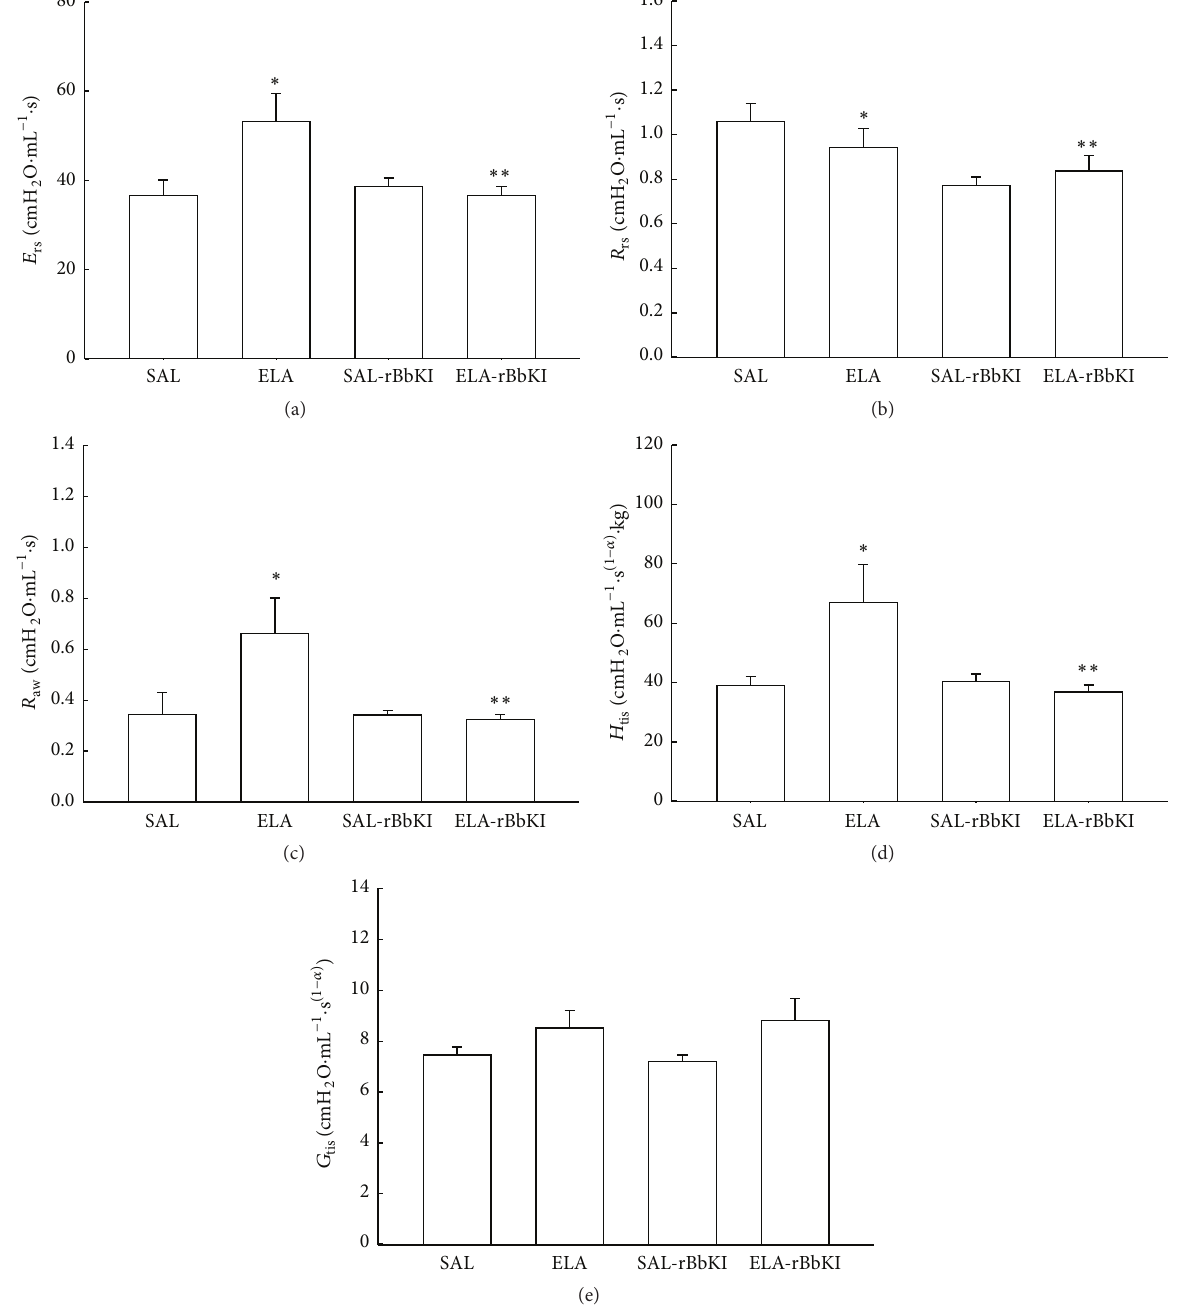
Figure3: Mechanical evaluation: respiratorysystemelastance (a), respiratorysystemresistance(b),airway resistance(c), lung tissueelastance (d), and lung tissue damping (e) ( ∗ 𝑃 < 0.05 compared with SAL and SAL-rBbKI groups; ∗∗ 𝑃 < 0.05 compared with ELA-rBbKI group).